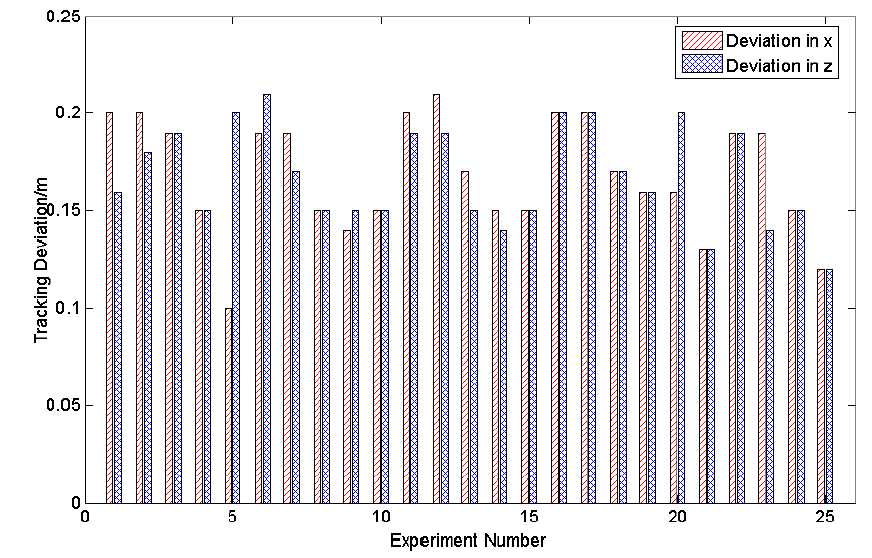
Figure 16. The tracking deviation between trajectories as tracked by a person’s skeleton vs. as computed by our method along the X and Z axes in Experiment 2, where 25 results selected randomly from 50 results are given.